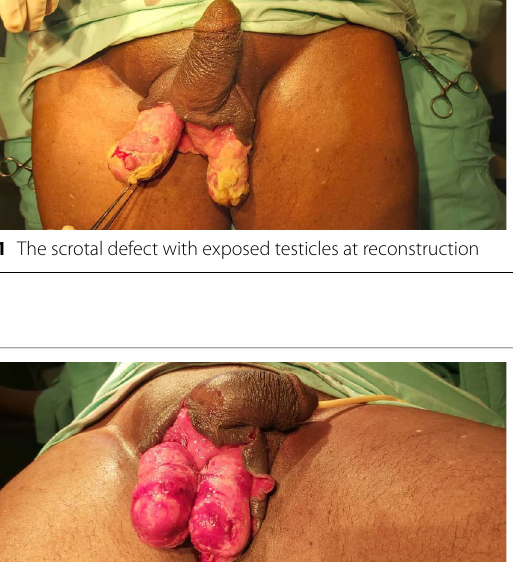
(Fig. 2). A proximal-based gracilis muscle flap was raised from the left thigh using a skin incision placed 4-cm-pos- terior to an imaginary line drawn from the pubic tuber- and externally rotated and the knee flexed (Fig. 3). The